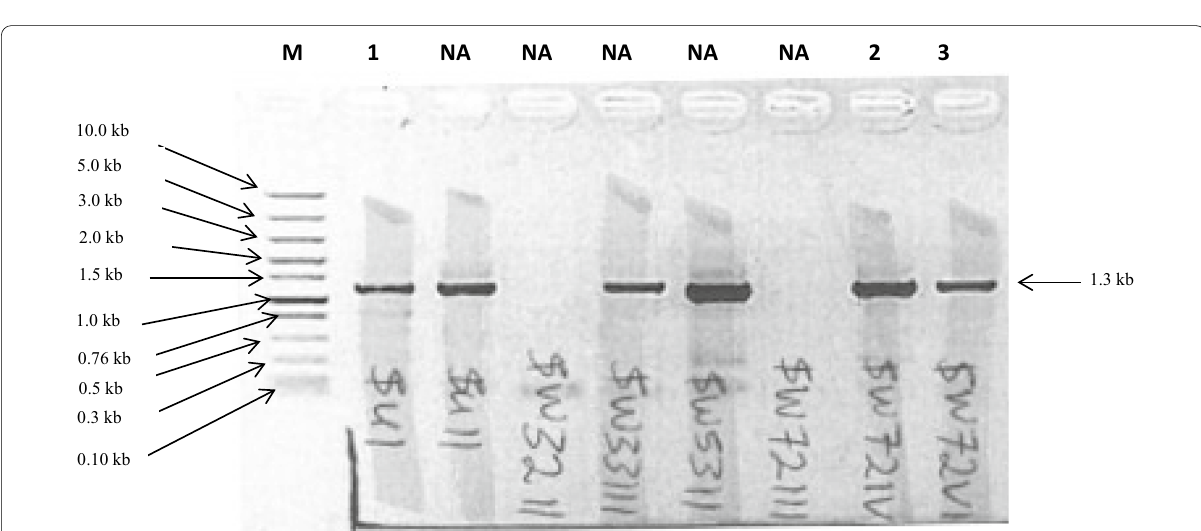
Fig. 2 Agarose gel electrophoresis (uncropped) of amplified 16S rRNA gene of genomic DNA using PCR. Lane M: standard marker (NEB’s fast DNA Ladder); Lane 1: Streptomyces sp. SUI, Lane 2: Streptomyces sp. SW72IV and Lane 3 Streptomyces sp. SW72VII (NA